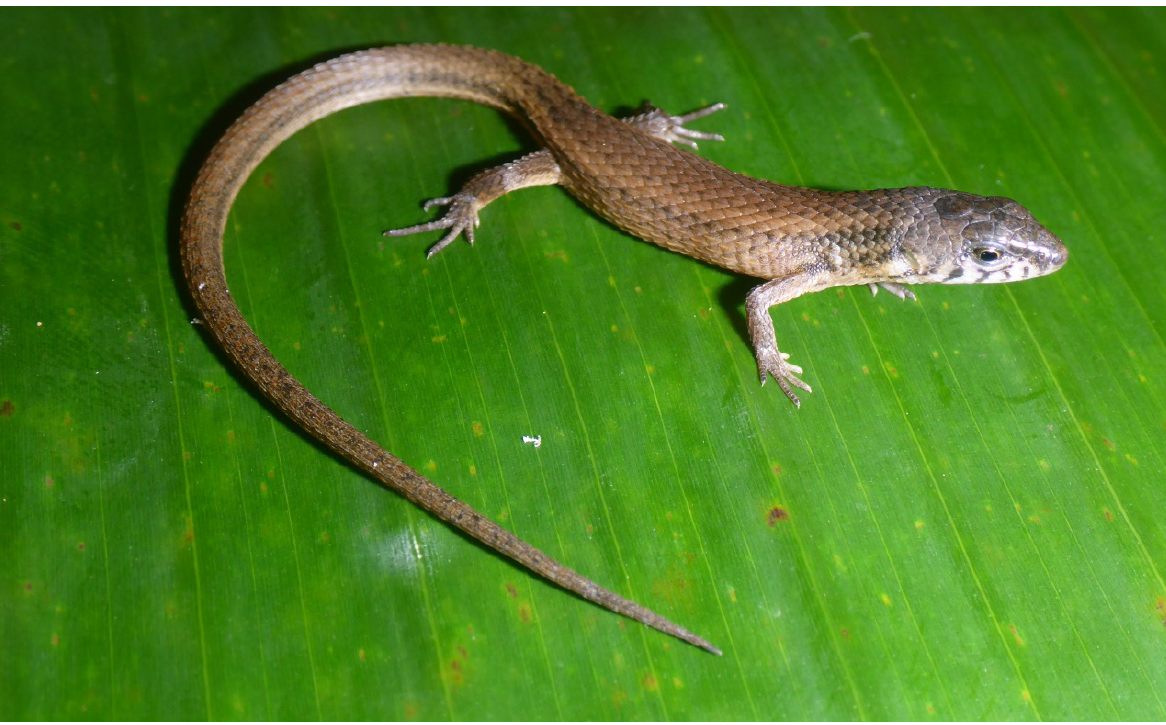
Figure 3. An individual of Loxopholis rugiceps (UVS-V-01232, Departamento de Cortés, Honduras) showing all the characteristics that separate this species from others in the